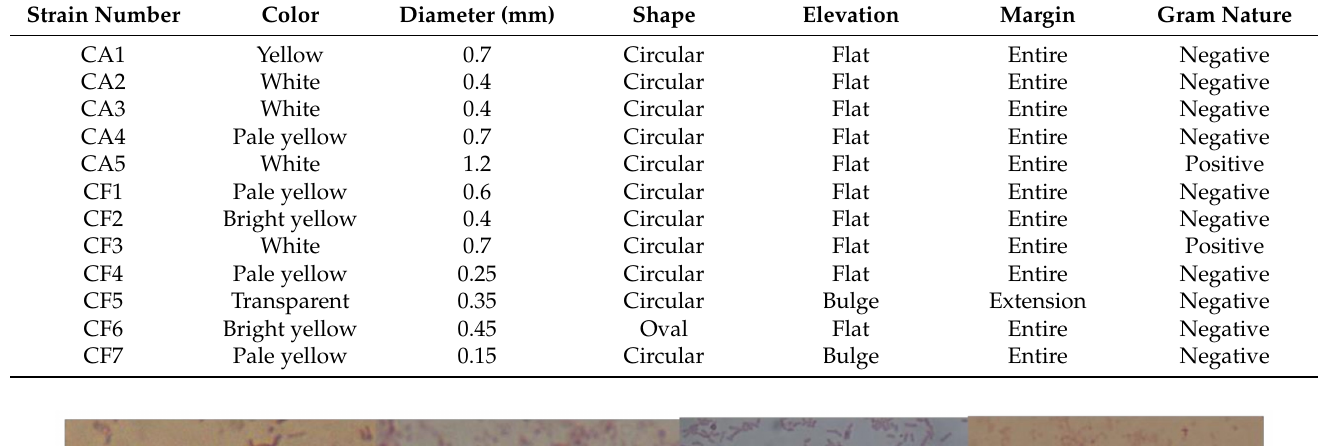
Table 2. Colony characteristics and Gram nature of phycosphere bacteria isolated from C. dentata .